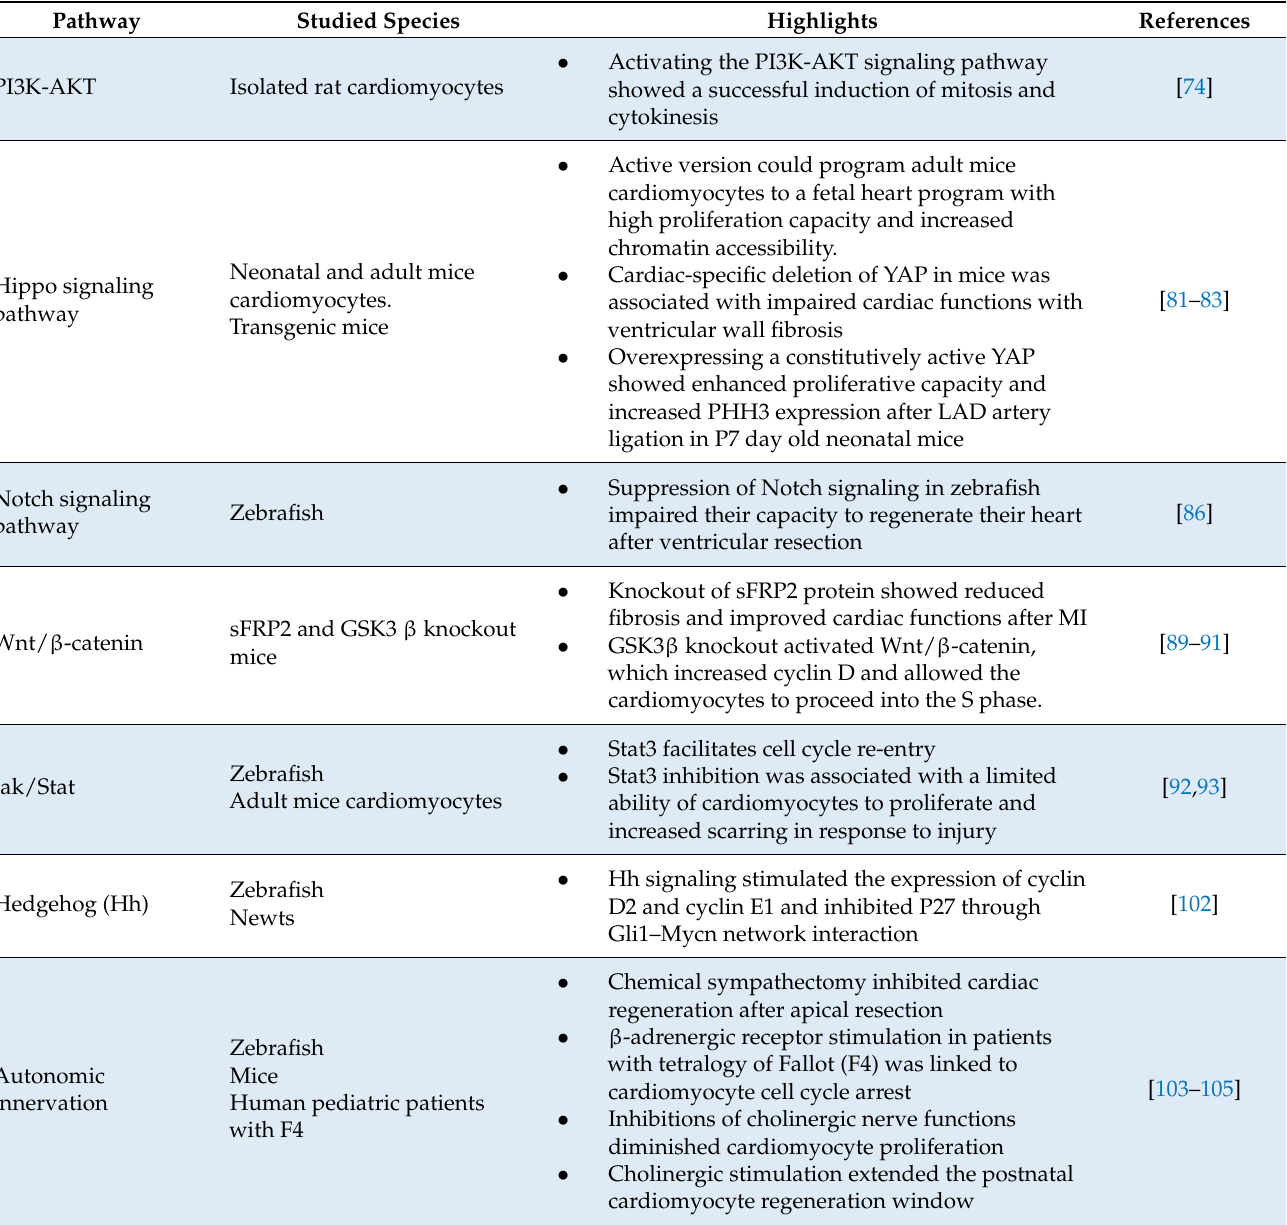
Table 4. Signaling pathways that influence cardiomyocyte cell cycle